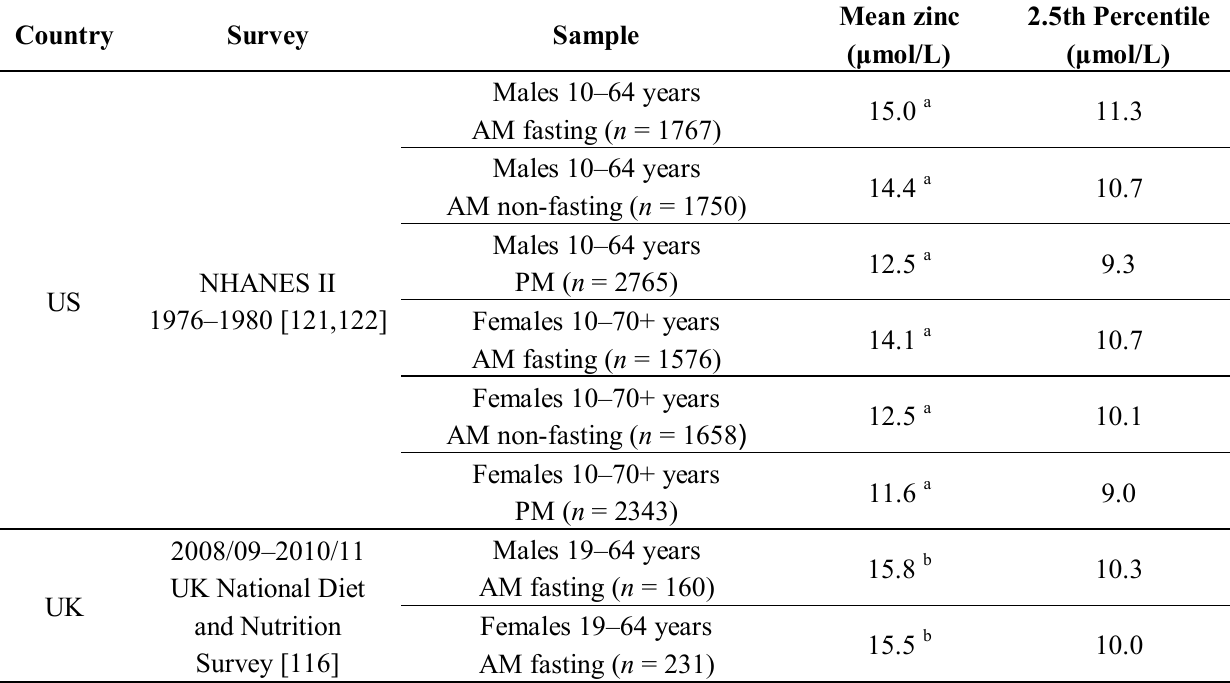
Table 7. Measurements of serum and plasma zinc in national surveys.